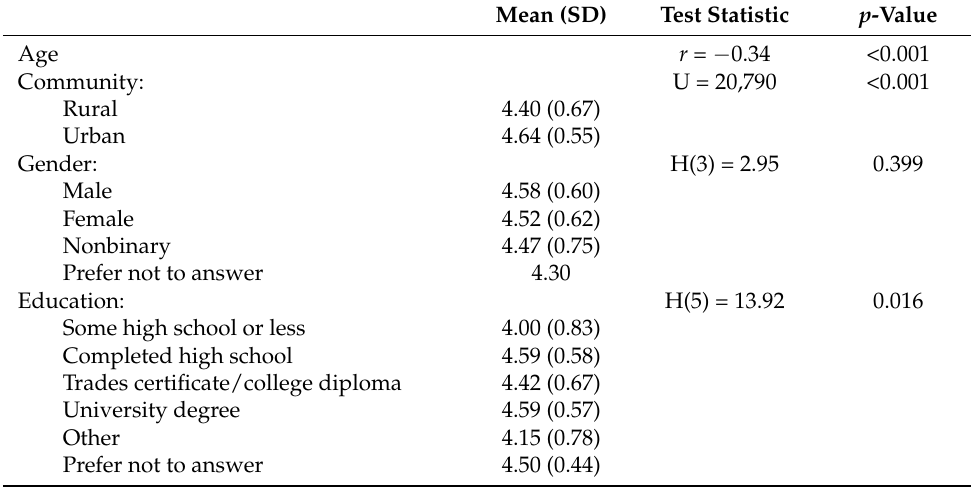
Table A8. Mobile Device Proficiency.